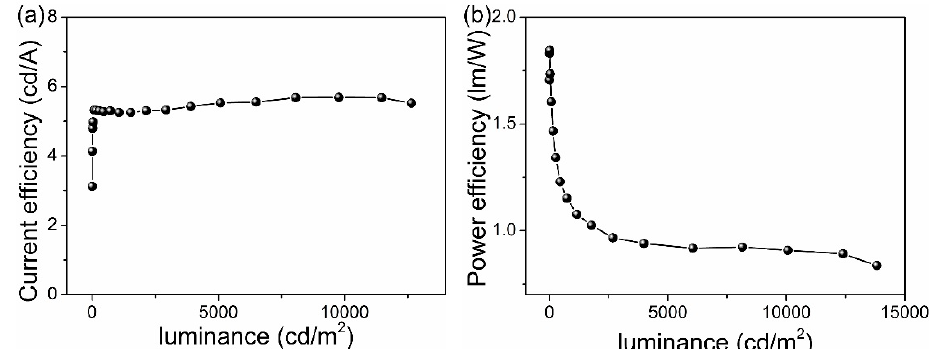
Figure 4. ( a ) CE versus luminance and ( b ) PE versus luminance for device C.